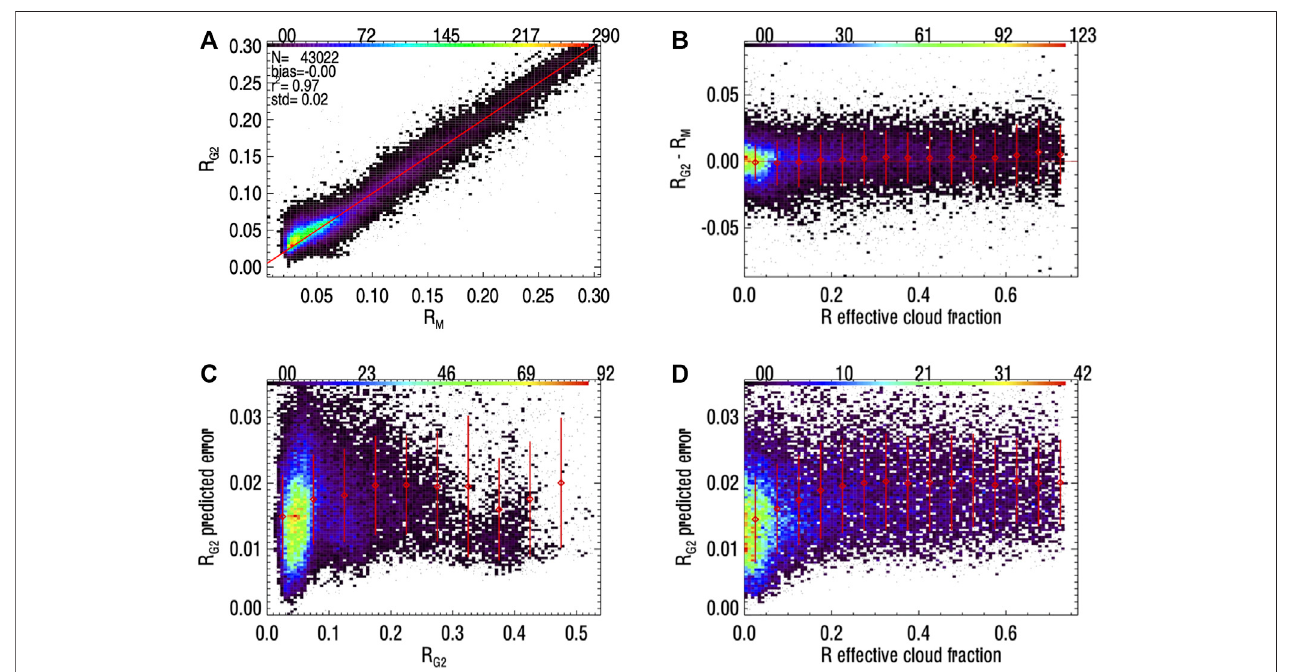
FIGURE 3 | Density plots using (independent) red band data (denoted “ R ” ) from August 2, 2018 with colors indicating the number of points in a bin as indicated alongthetop;binswithasinglepointareindicatedasadotratherthana fi lledbox; (A) scatterdiagramofthepredictedsurfaceredre fl ectancefromMODISMCD43(R M ) versusthatreconstructed fromallskyGOME-2data(R G2 )withstatisticsincludingthenumberofpoints(N)andstandarddeviation(std)andthe1:1lineshowninred; (B) R G2 – R M as a function of the effective cloud fraction f c computed with the GOME-2 R band (higher f c values indicate higher geometrical cloud fractions and optical thicknesses).Reddiamondsindicatebinnedmeansandredverticalbarsthebinnedstandarddeviations; (C) predictedR G2 errorsasafunctionofR G2 ; (D) predictedR G2 errors as a function of f c computed with the red (R) band.